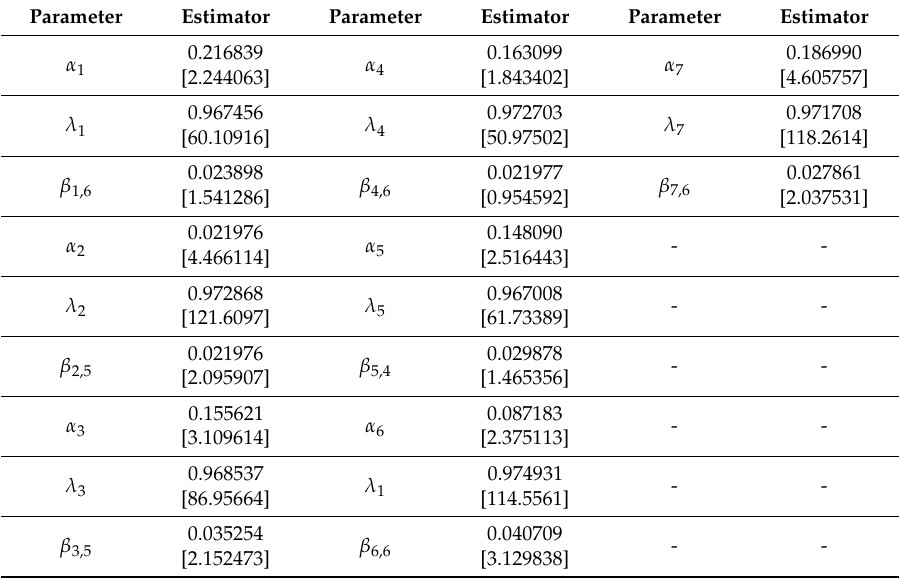
Table 6. Estimation results of parameters for MIDAS( m , K , h )-AR(1) model under Brent oil